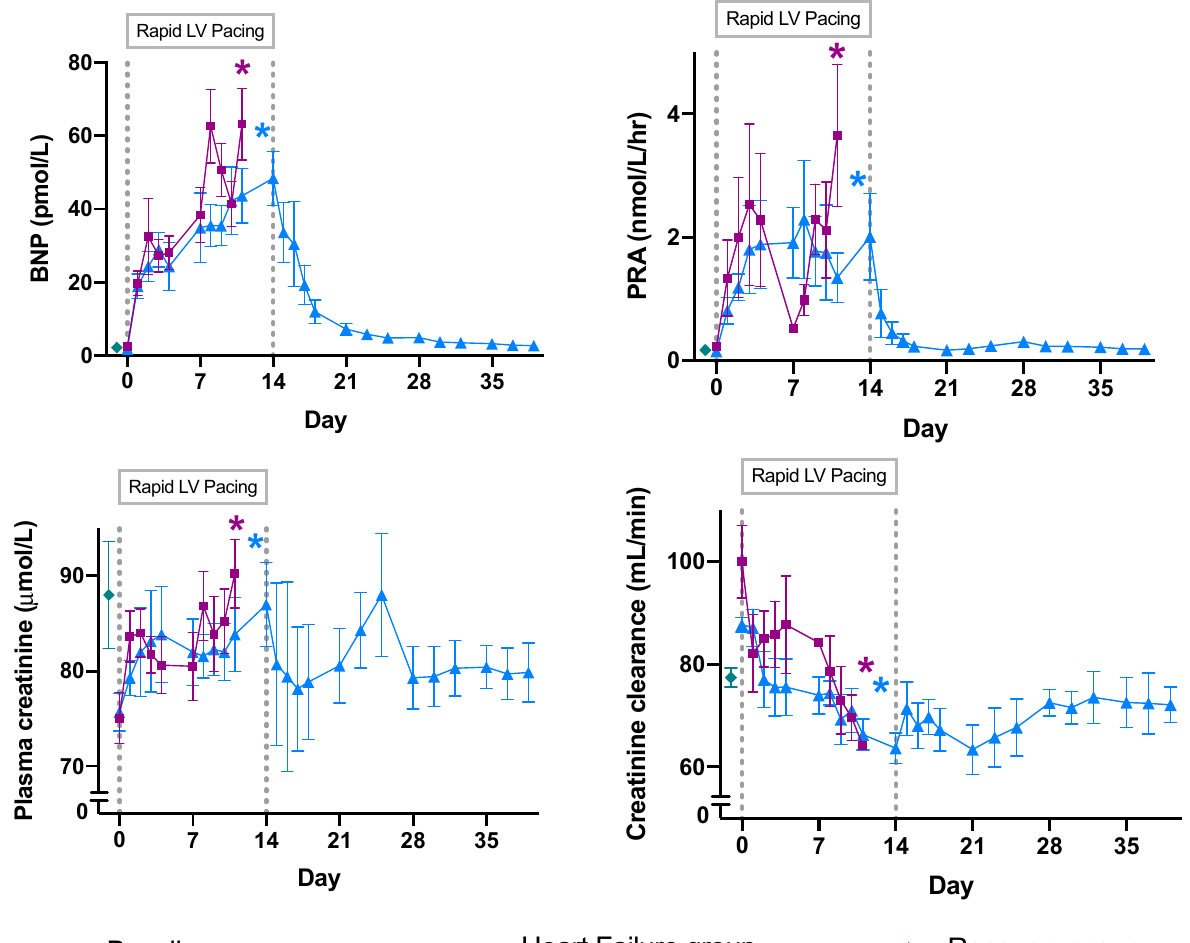
Figure 1. Mean ± standard error of the mean of serial physiological responses of sheep before and during the development of pacing-induced acute decompensated heart failure, and during 25 days of recovery following the cessation of pacing. Vertical dashed line at day = 0 represents the initiation of left ventricular pacing; vertical dashed line at day = 14 represents the termination of pacing. Sheep in the Heart Failure group were paced at 180 beats per minute (bpm) for 7 days, followed by pacing at 225 bpm for 4 days. Sheep in the Recovery group were paced at 220 bpm for 14 days. These data highlight the serial changes in physiological measures in response to the initiation and cessation of pacing within each group, with significant differences from day 0 shown by asterisks (paired-samples t -tests, p < 0.05). Pacing resulted in an increase in B-type natriuretic peptide concentration, an increase in plasma renin activity, an increase in plasma creatinine, and a decrease in creatinine clearance in both groups of paced animals (HF and Recovery). Although the HF and Recovery groups were exposed